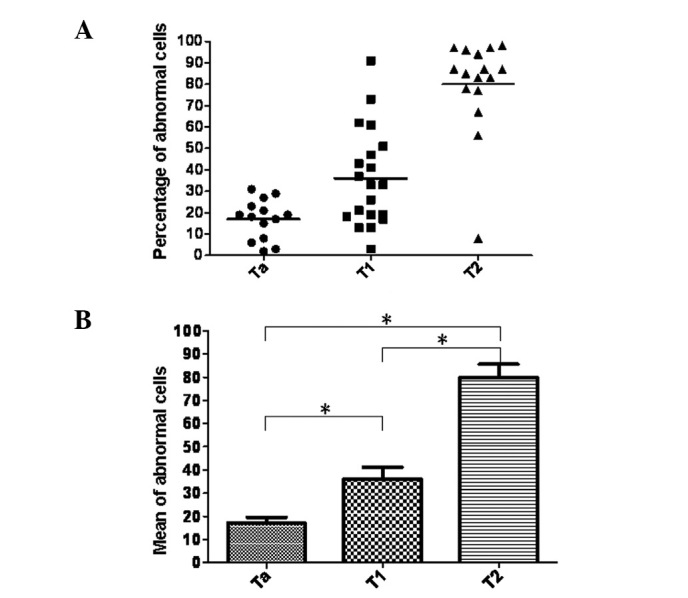
Statistical analysis of the correlation between abnormal cells and tumor stage. (A) Distribution of abnormal cells in various tumor stages. (B) The number of abnormal cells in the pT1 and pT2 (invasive) stages was higher than that in non-invasive Ta stage bladder cancer (P<0.05). The same relationship was also observed between muscle-invasive pT2 stage and non-muscle-invasive pTa, pT1 stages (P<0.01) *Statistically significant difference, as stated.